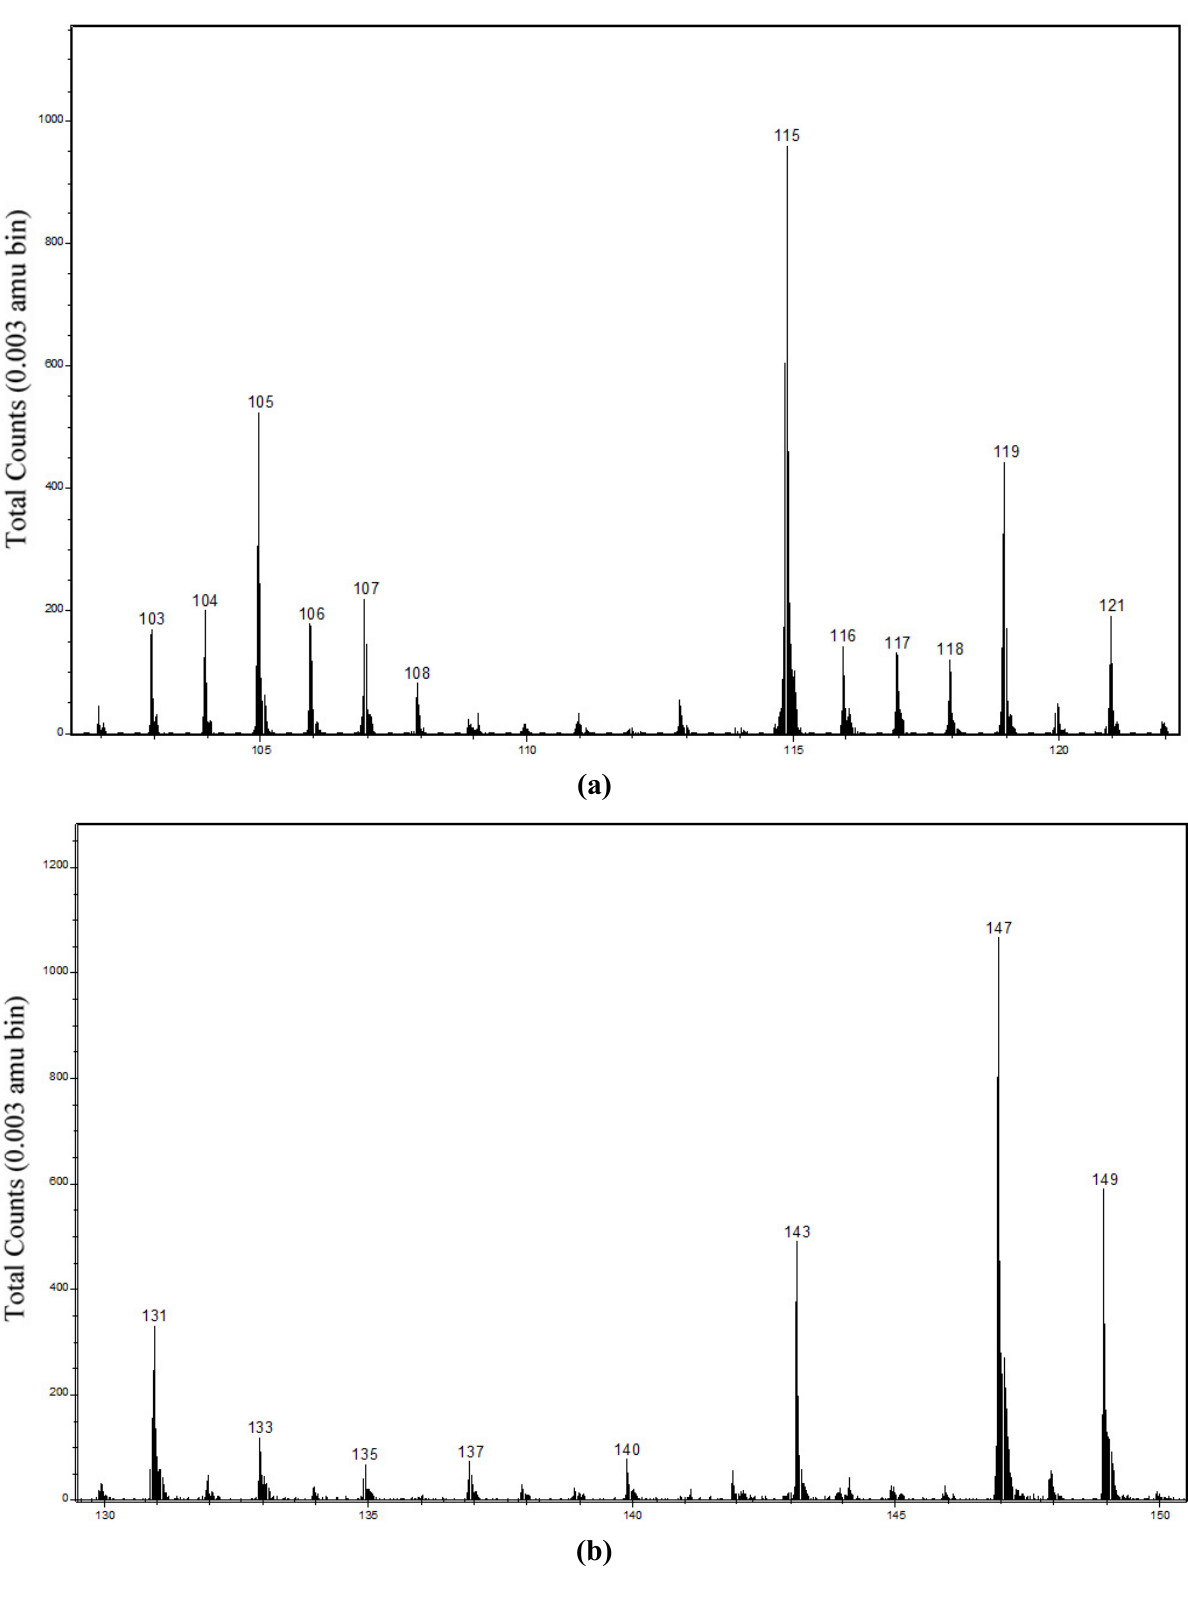
Figure 4. ( a ) Positive secondary ion mass spectrum in m/z 102–122 region; and ( b ) negative secondary ion mass spectrum in m/z 130–150 region from bulk Cu